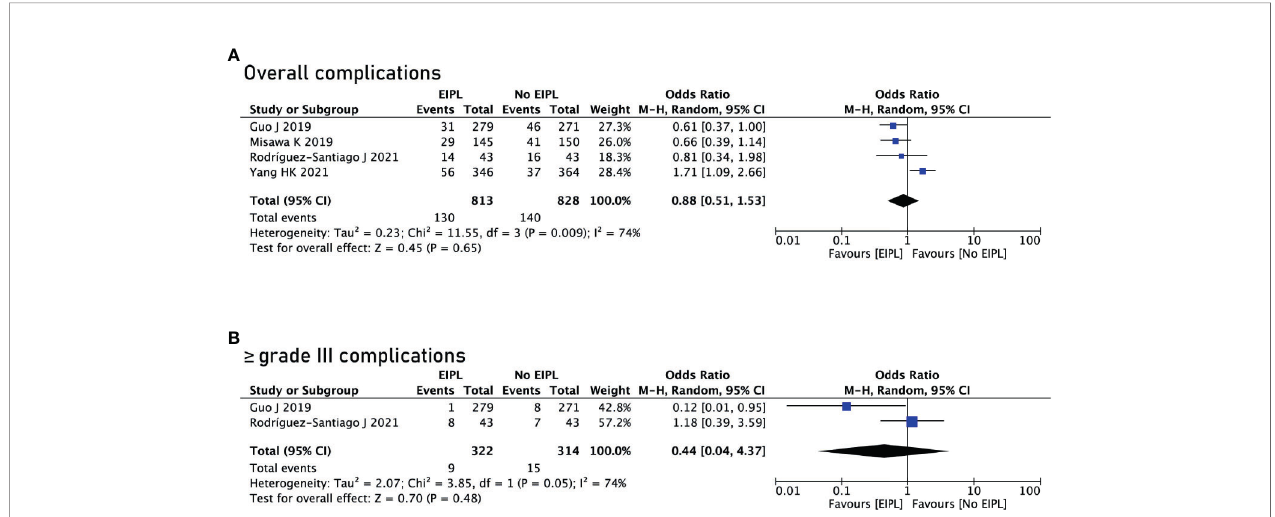
FIGURE 3 | Comparison of complications between EIPL group and No EIPL group. (A) Overall complications. (B) ≥ grade III complications. EIPL, extended intraoperative peritoneal